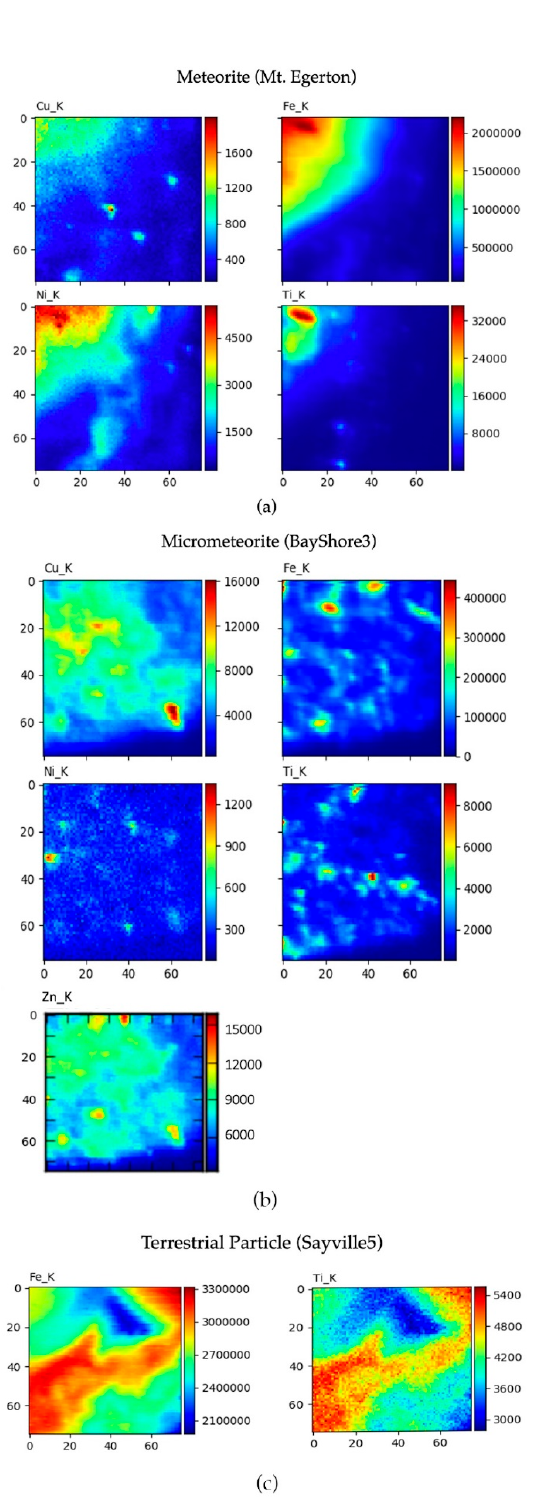
Figure 5. Spectral maps are a 2-D scan of the intact particle. The scan area shows key elements, including copper, iron, nickel, titanium, and zinc, in representative samples. These maps use color to show the location of the elements within the 40 × 40 µ m scan area of each sample as well as relative numbers of counts for each element. The red indicates spots of high counts for the element while a blue color is low counts. Mount Egerton ( a ), a documented meteorite, contains a similar chemical structure to the BayShore3 micrometeorite ( b ) while Sayville5 ( c ) is terrestrial in origin due to a lack of key elements being present in extraterrestrial samples.